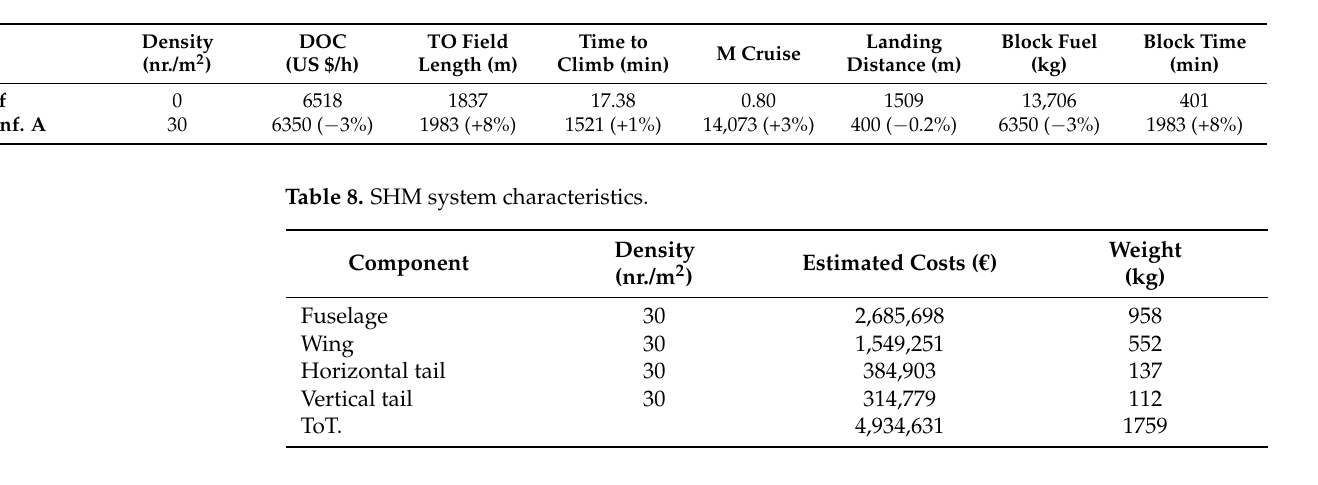
Table 7. Aircraft performance and DOC at different sensors density for the design mission.